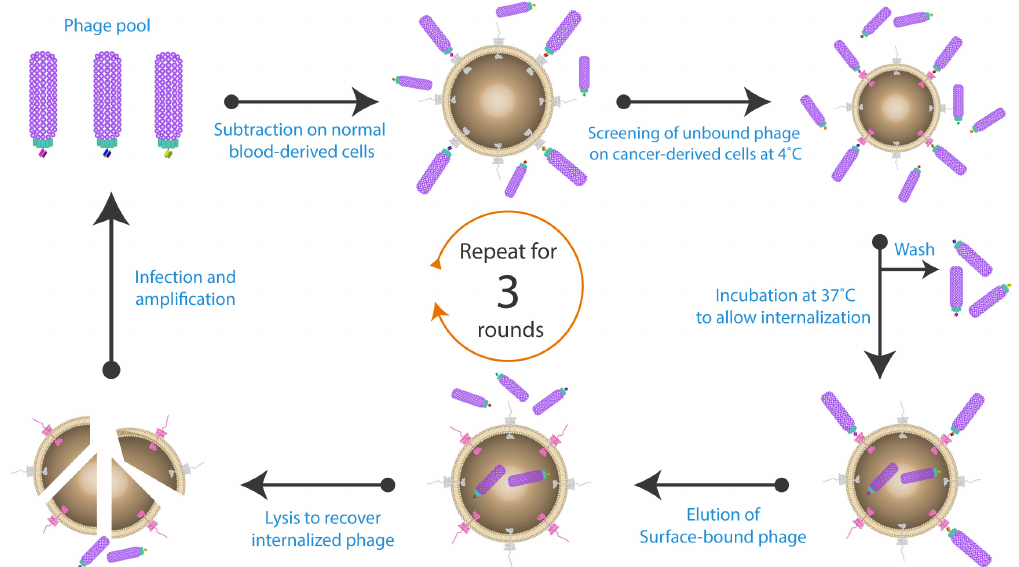
Figure 5. Isolation of specific internalizing antibodies by phage display. The antibody-phage library was initially subtracted on healthy cells, and then the free phage were screened on cells harbouring the antigen of interest. A washing step was performed to remove all the non-specific and unbound phage. All the previous steps were conducted at 4 ◦ C. The cells were then incubated at 37 ◦ C to induce phage internalization. Cell surface bound phage were removed by low pH elution buffer, while the internalized phage were retrieved by cell lysis. The isolated phage particles were then amplified and used for subsequent panning rounds. Figure shows methodology described by Fitting et al. [130].